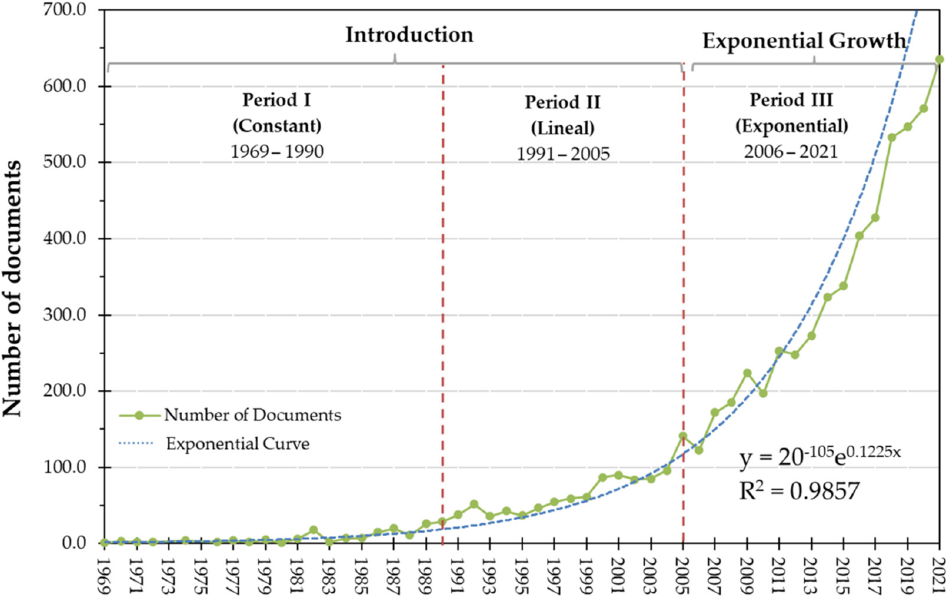
Figure 2. Scientific production of